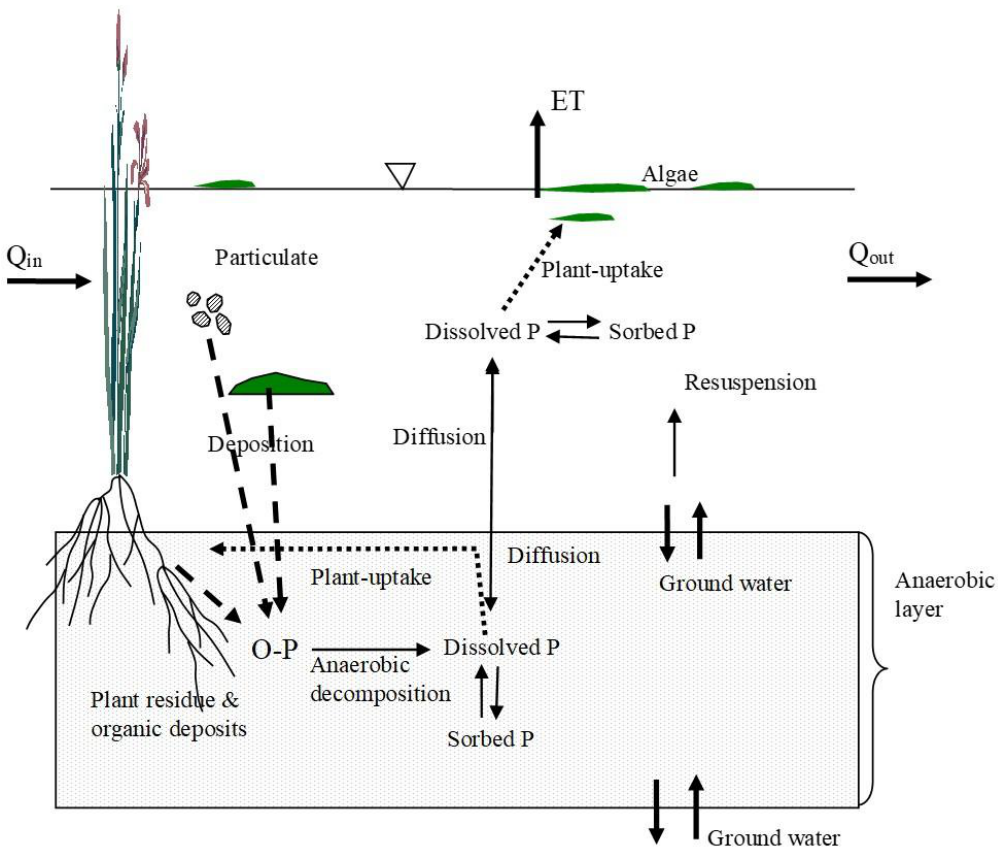
Figure 3. Schematic diagram of phosphorus processes in wetlands, including the water column and reduced soil layer. Figure modified and reproduced from Hantush, et al. [11].